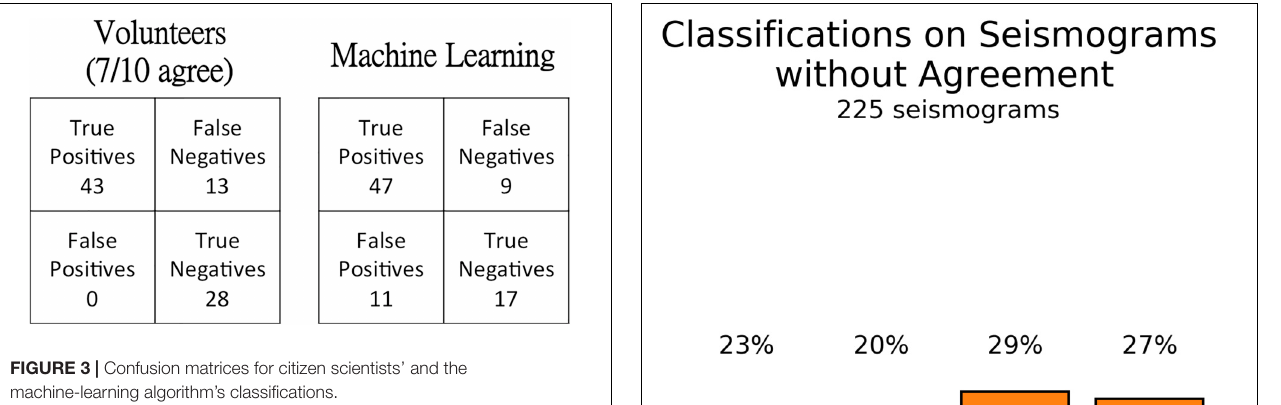
are the coefficients of orthogonal linear combinations of the variables in the dataset. Contours indicate the distributions of the training dataset and the symbols represent the testing dataset. The machine-learning algorithm achieved only 76.2% accuracy in classifying earthquakes in the same dataset, a score nearly 10% lower than citizen scientists ( Figure 4 ).